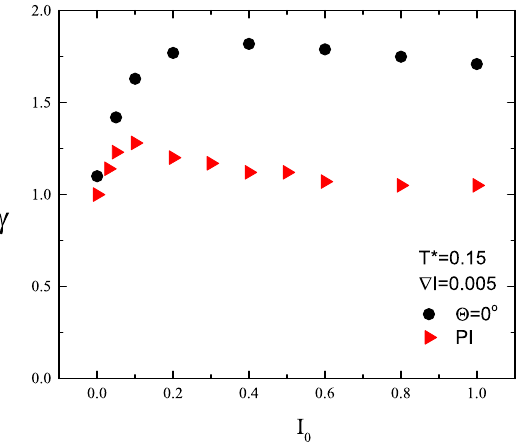
Figure 14. Exponent γ for light illumination with gradient ∇ I = 0.005. FPM with Θ = 0 ◦ (black circles) and PI model (red triangles). Experimental errors are of the size of graphical